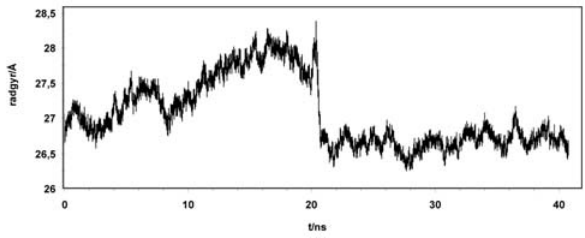
Fig. 5. Protein backbone radius of gyration obtained during 40.8 ns of productive MD simulation of DPP III in complex with the inhibitor.